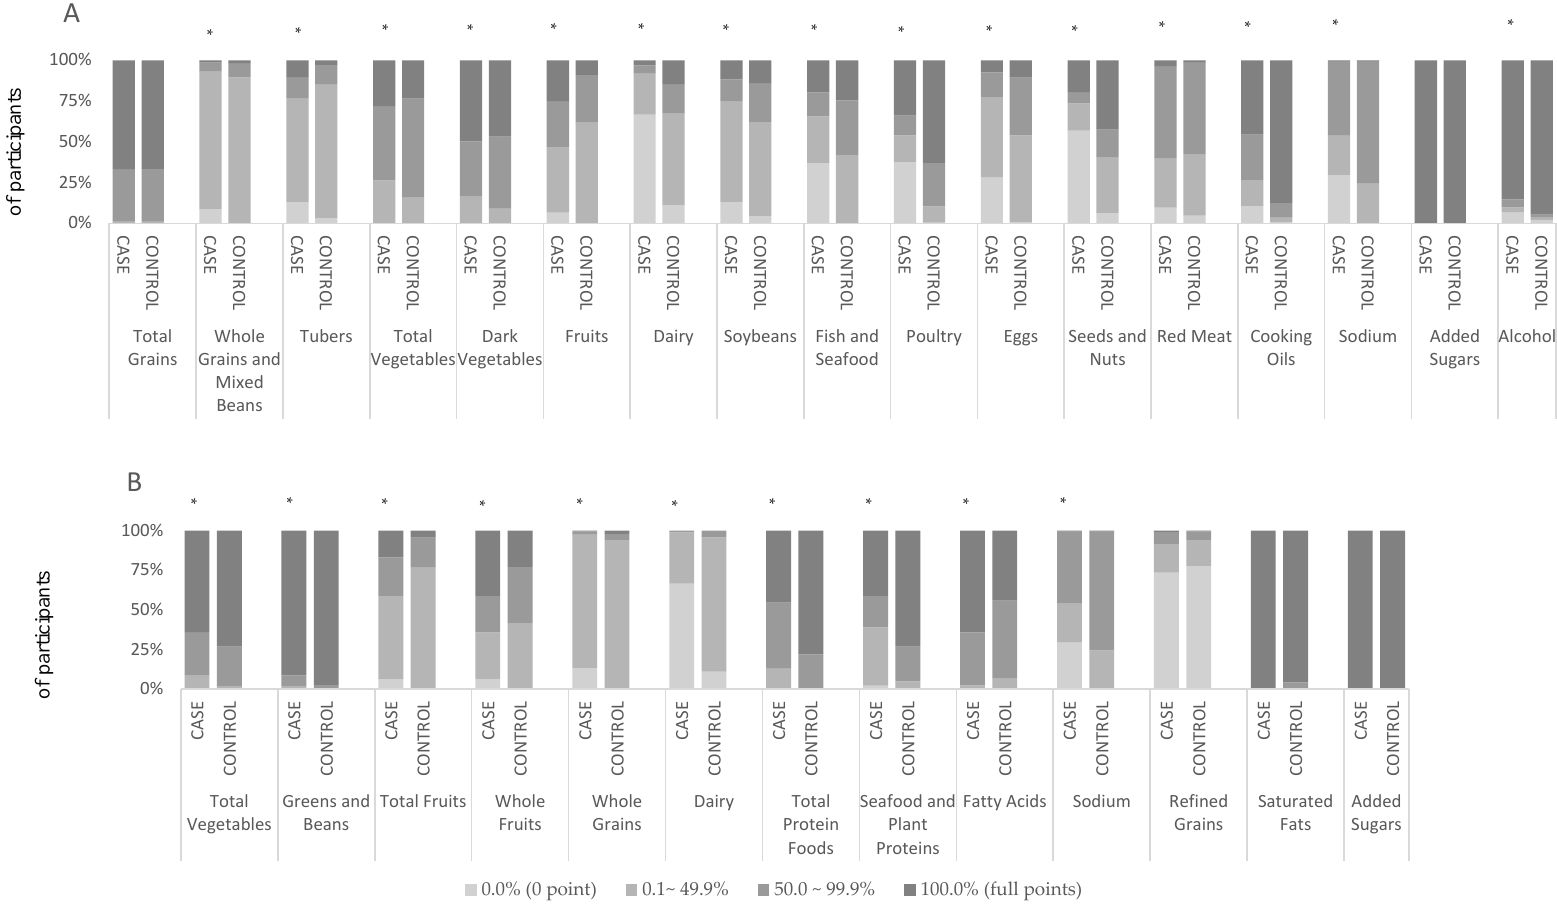
Figure 1. Comparison of the percentage distribution of the cases and controls according to the scores of each item for the CHEI (A) and the HEI-2015 (B). For fruits, sodium and cooking oils in the CHEI and whole grains, dairy, fatty acids, refined grains, sodium, added sugars and saturated fats in the HEI-2015, the cutoffs for the four groups are 0.0, 0.1–4.9, 5.0–9.9 and 10.0. For the remaining components in the CHEI and the HEI-2015, the cutoffs for the four groups are 0.0, 0.1–2.4, 2.5–4.9 and 5.0. *: p < 0.01 (chi-square